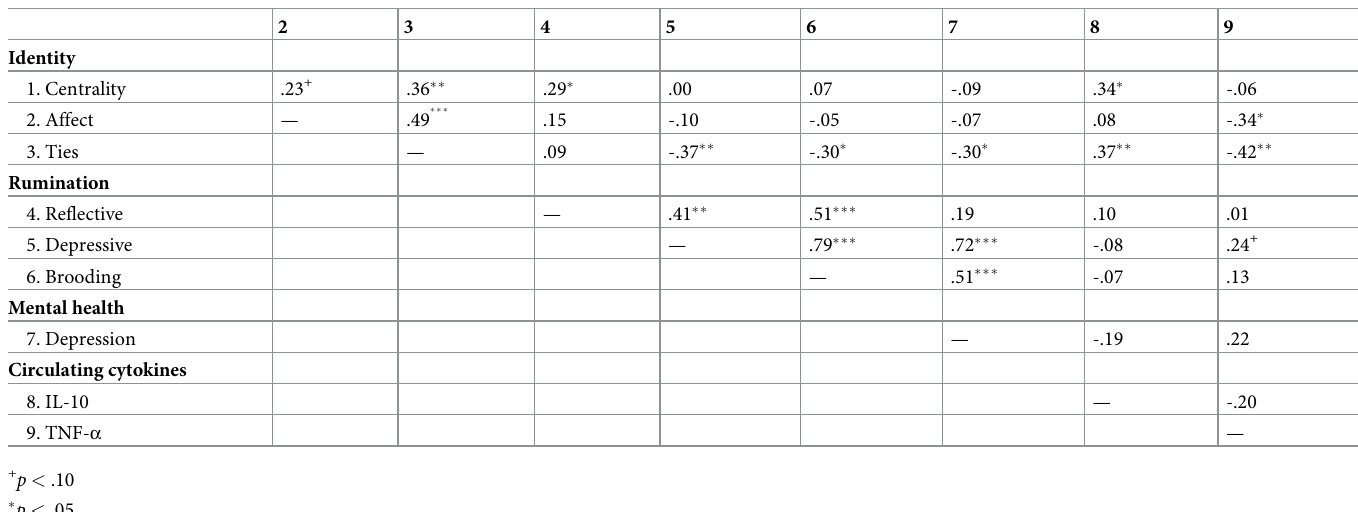
Table 2. Inter-correlations among Study 2